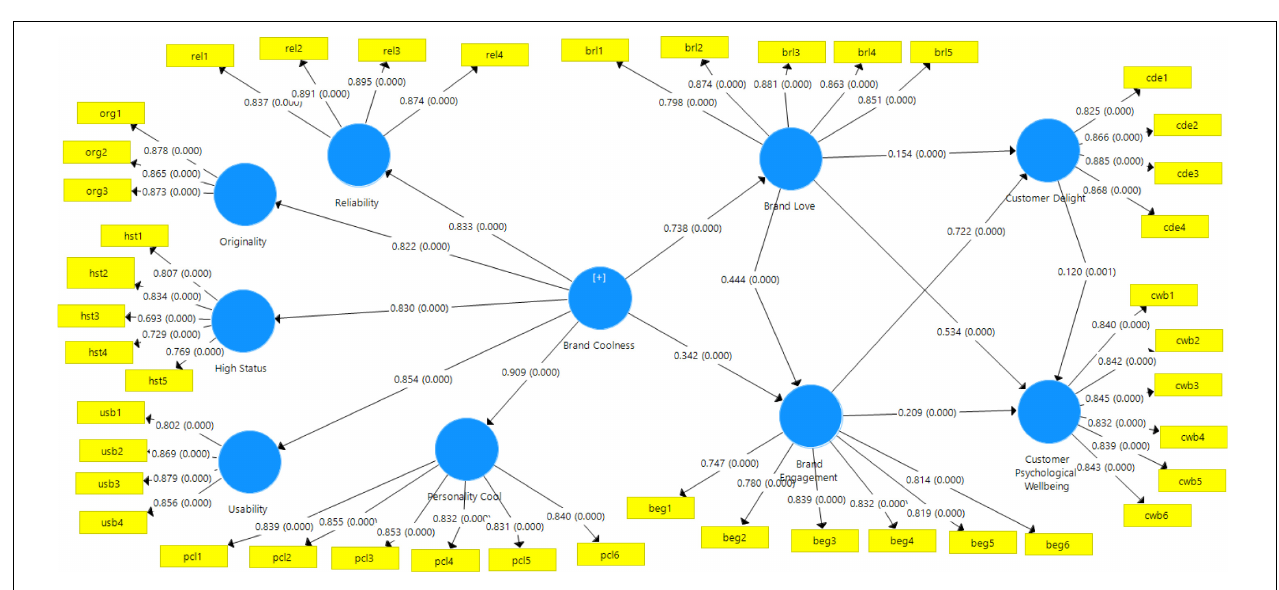
FIGURE A1 | Structural